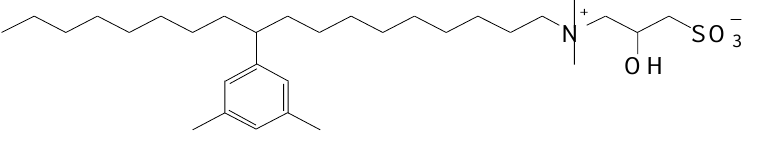
Figure 13. The structure of aralkyl substituted alkyl sulfobetaine (BSB).